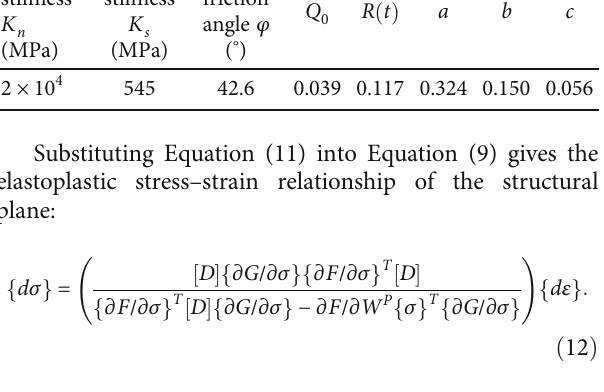
0 Measured curve Fitting curve Figure 12: Fitting curves of structural plane parameters with an undulating angle of 30 ° . Table 5: Physical and mechanical parameters of the structural plane. Normal